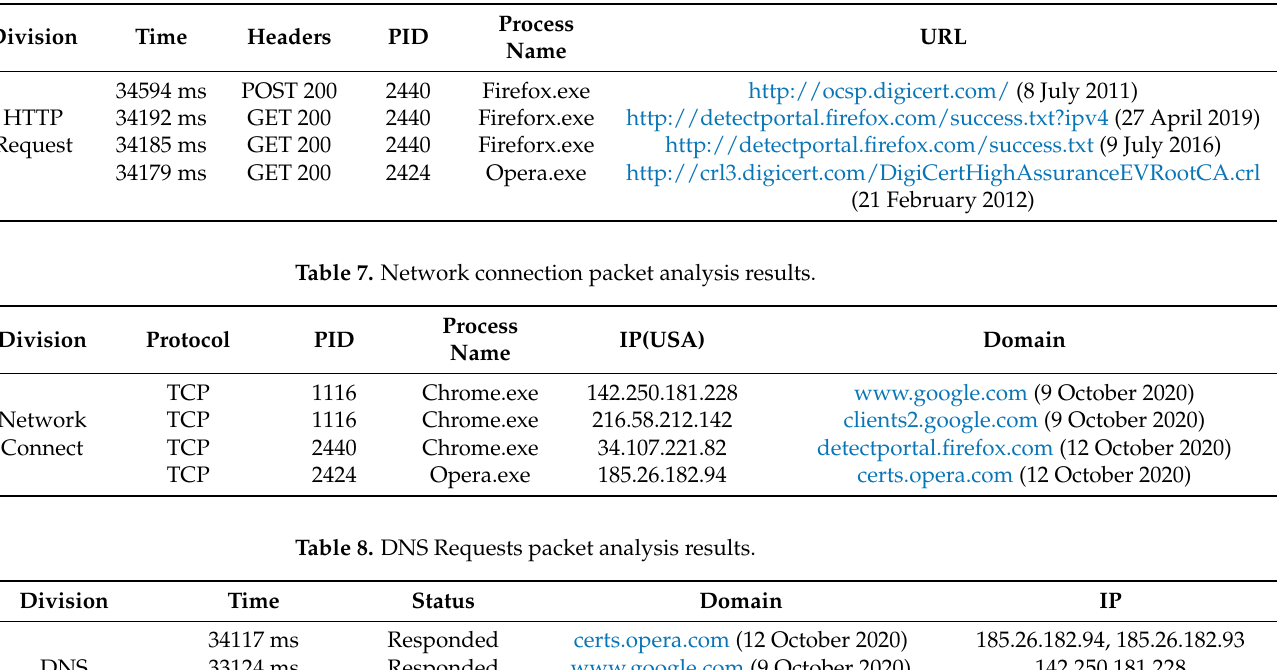
Table 6. HTTP request packet analysis results.